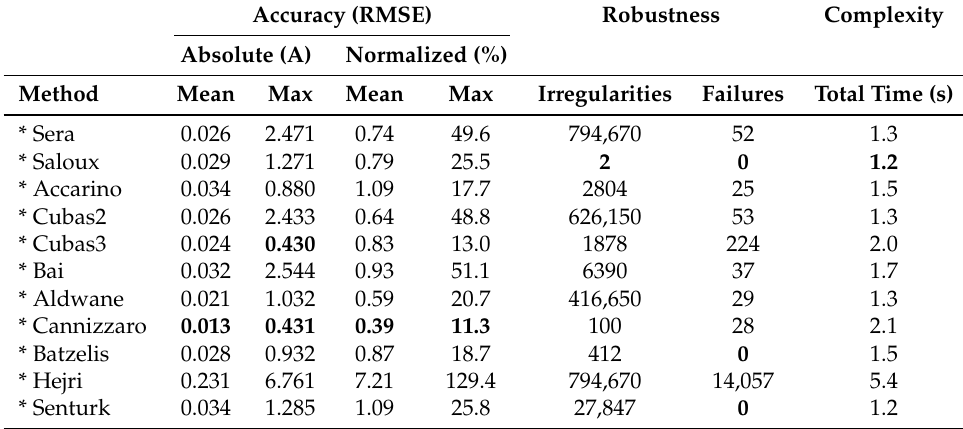
Table 5. Performance of the methods that rely solely on datasheet